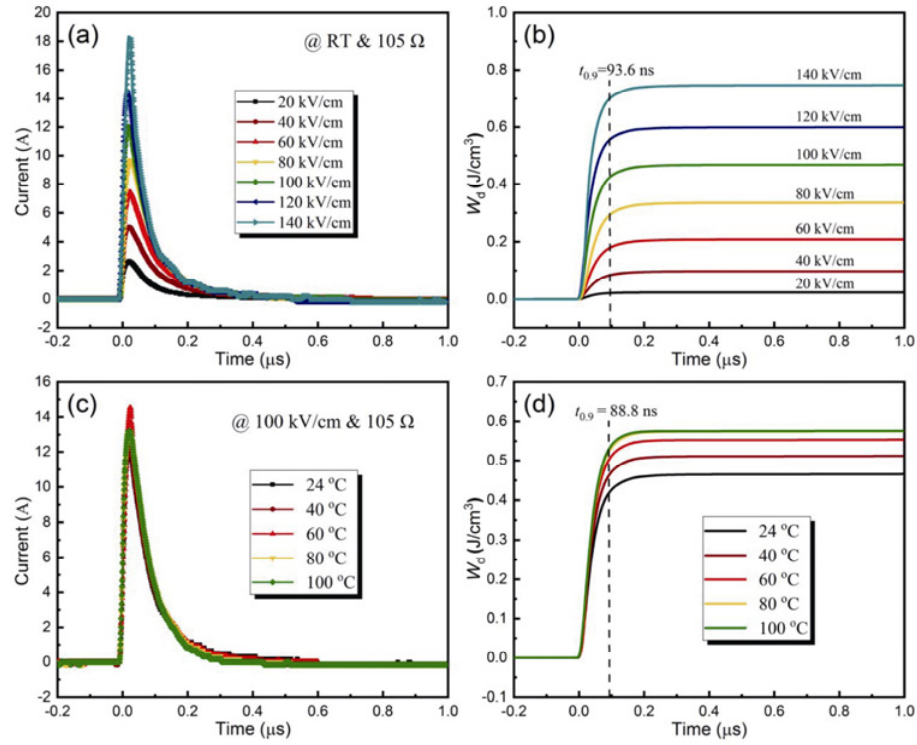
Fig. 12 (a) Overdamped discharge curves and (b) W d of BS 0.5 BNT–14GS ceramic composite under different electric fields; (c) overdamped discharge curves and (d) W d of BS 0.5 BNT–14GS ceramic composite under different